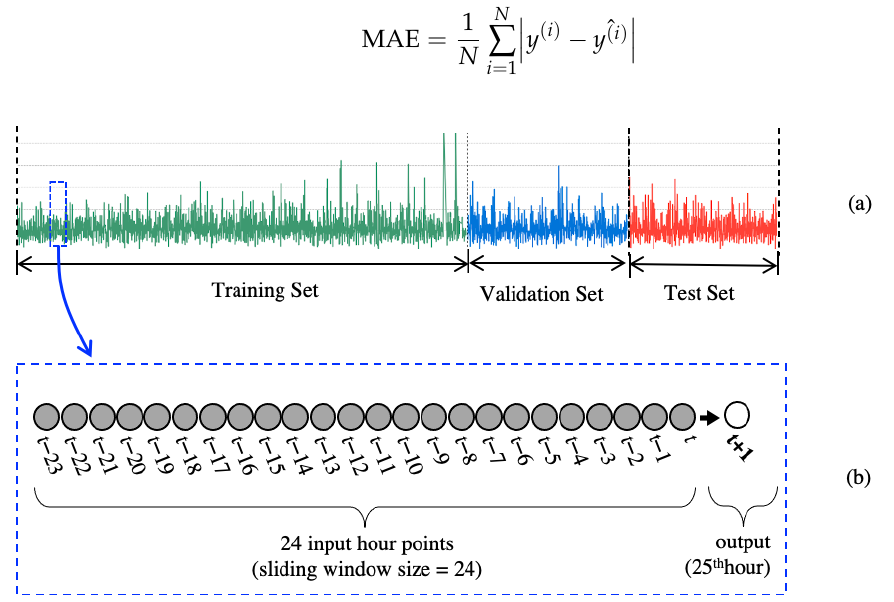
Figure 7. ( a ) The split of the time-series data into a training set and a test set, and ( b ) an example of an input with a sliding window size of 24 and one output.